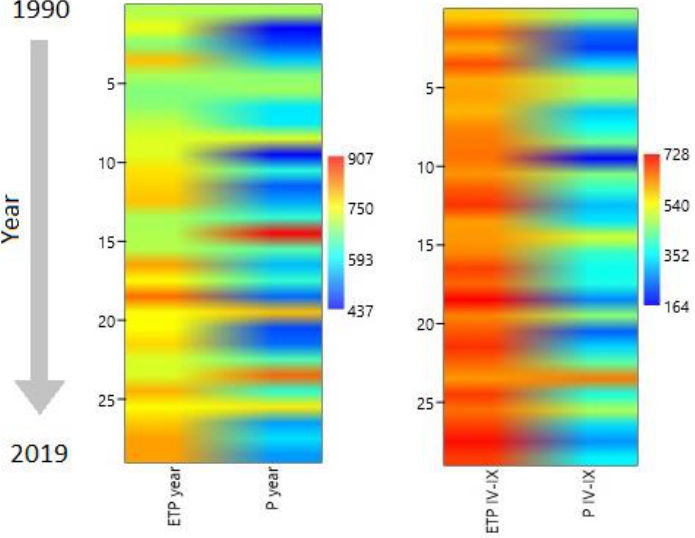
Figure 16. Positioning of evapotranspiration compared to temperature, according to the values recorded annually at the Regional Meteorological Center Banat-Crisana, Romania, 1990–2019.